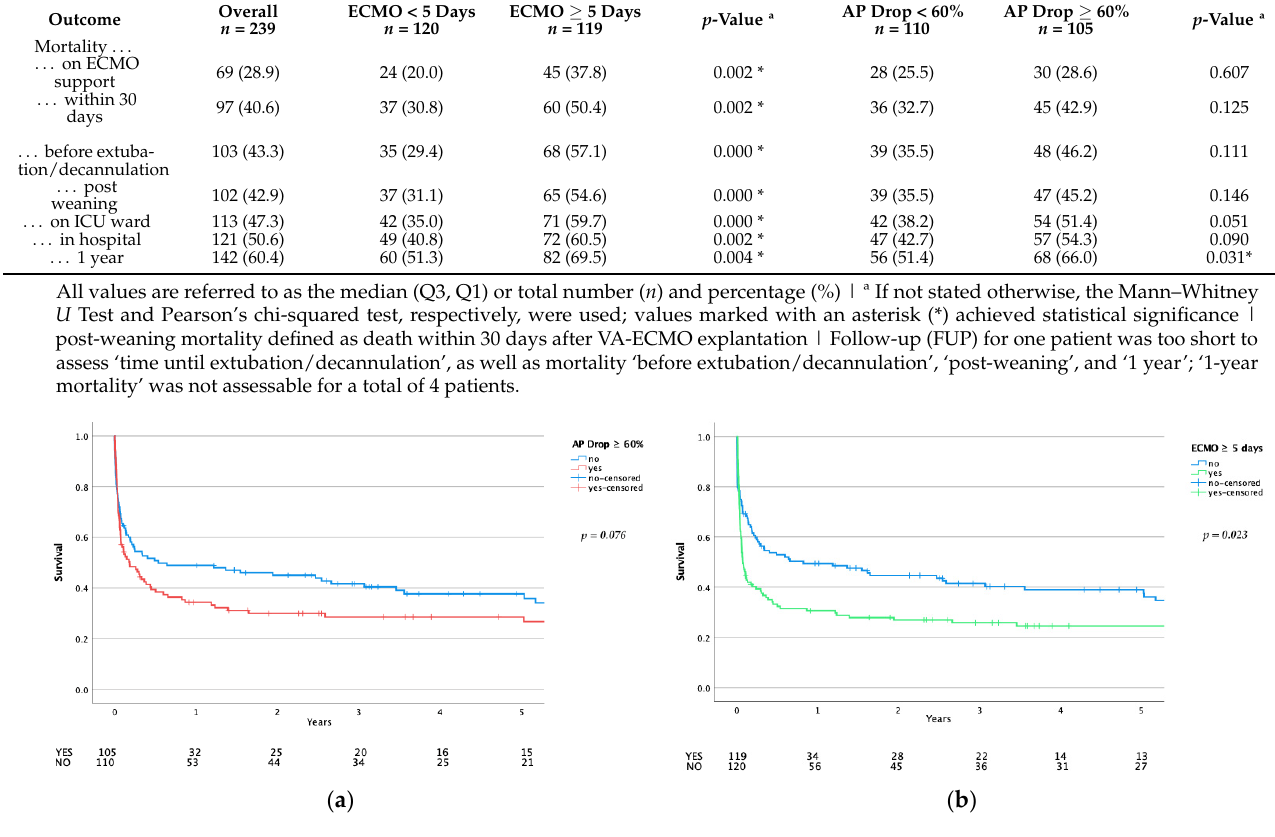
Figure 4. Five-year survival. ( a ) Long-term survival comparison dependent on the initial drop of alkaline phosphatase. ( b ) Long-term survival comparison dependent on the ECMO duration. p -values calculated using the log-rank test.